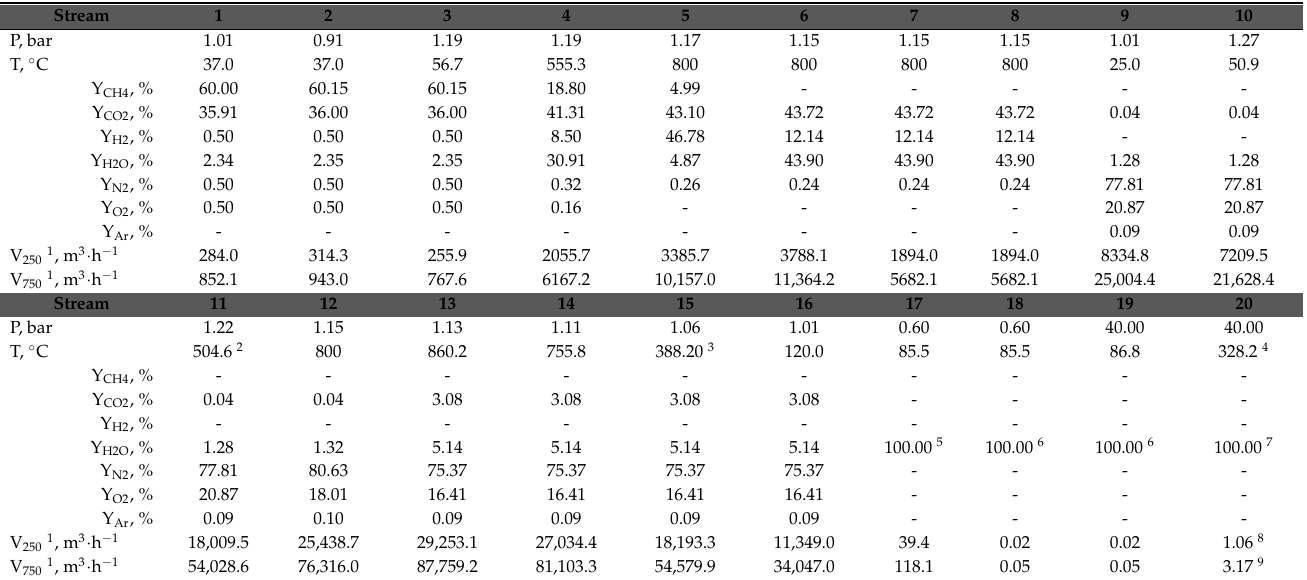
Table 2. Flowrates, molar fractions and operational conditions of the biogas-SOFC CHP system of Figure 1, for SOFC operation at maximum power